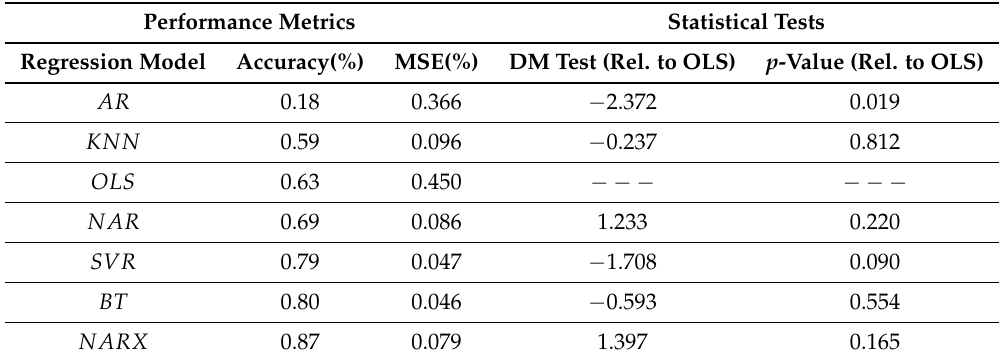
Table 3. Performance metrics comparison with other regression models and DM test related to the comparison with benchmark OLS